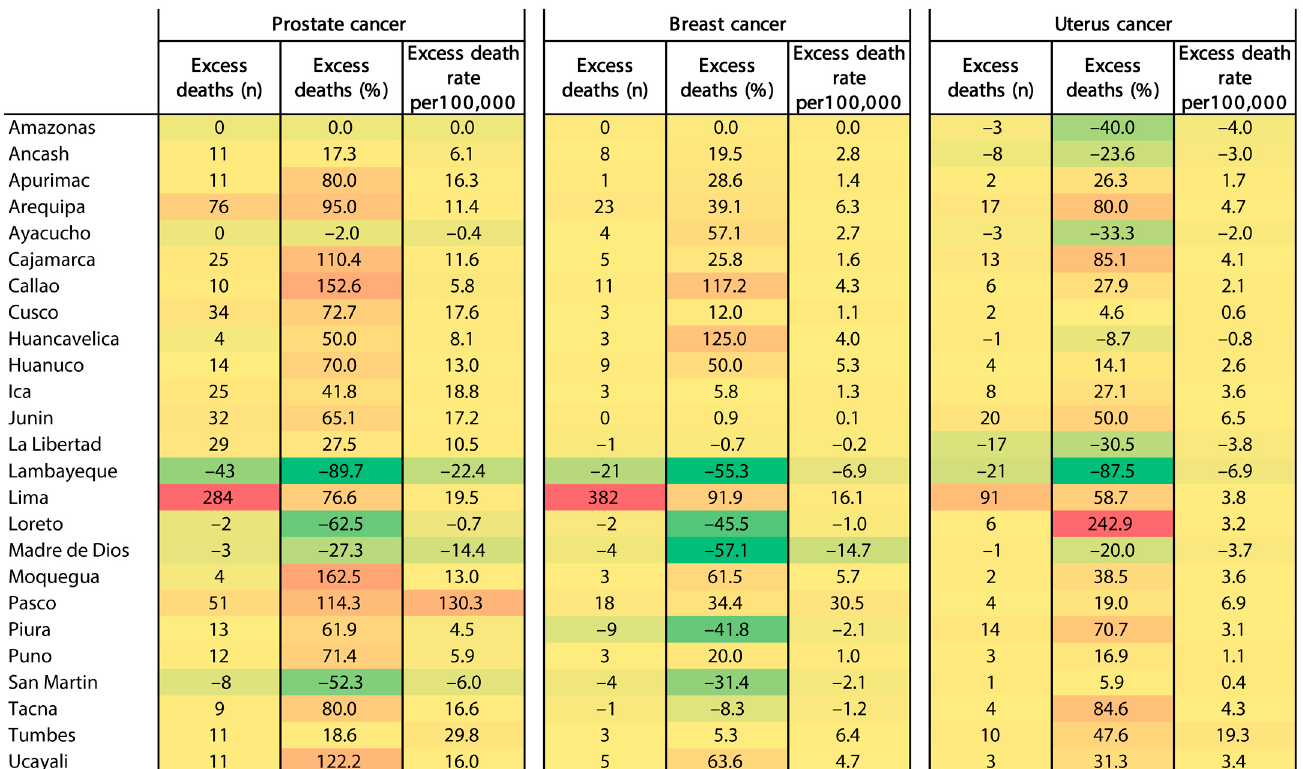
Figure 7. Excess deaths (n, % (P-score)) and excess death rates (per 100,000 habitants) by prostate cancer, breast cancer, and uterus cancer, stratified by regions in Peru. Color intensity is proportional to rank number (from 382 denoted by dark red, to − 89.7 denoted by dark green). Negative values mean a reduction in deaths.